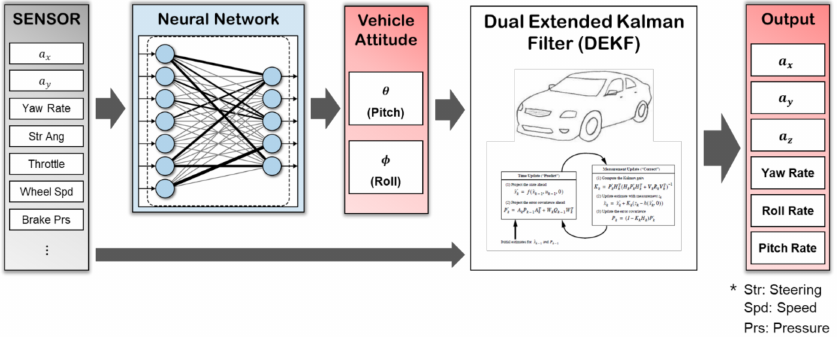
Figure 1. Architecture